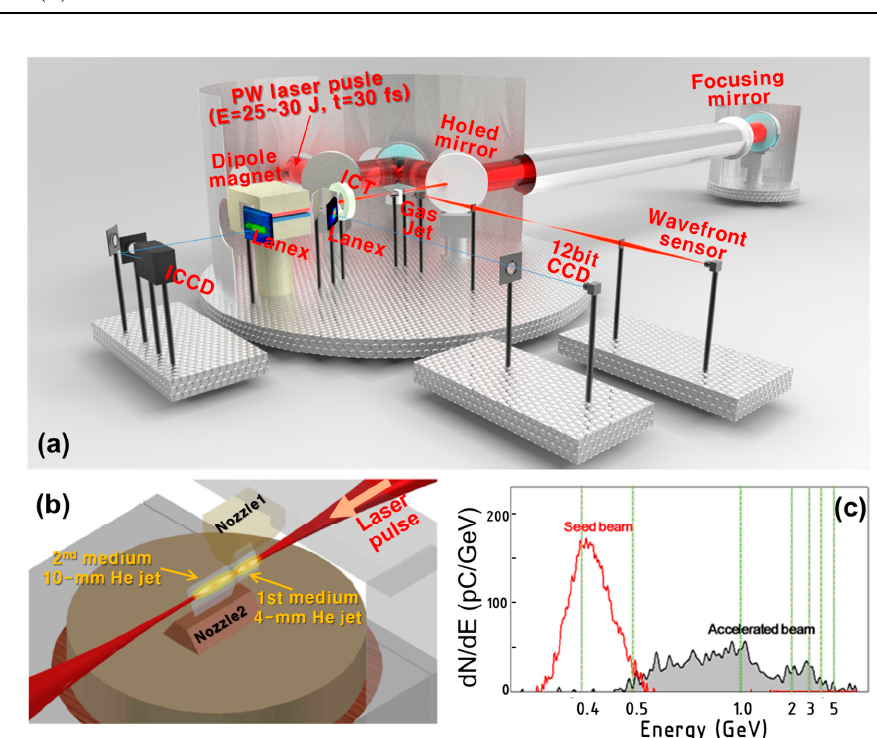
Laser pulse duration